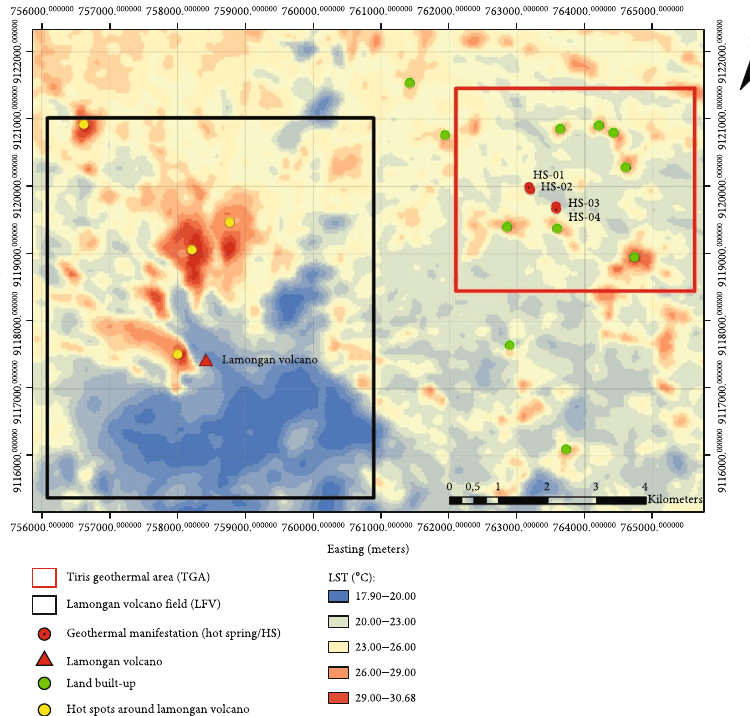
Figure 3: Estimation of LST from satellite coverage for the Tiris geothermal area of the Lamongan Volcano complex.